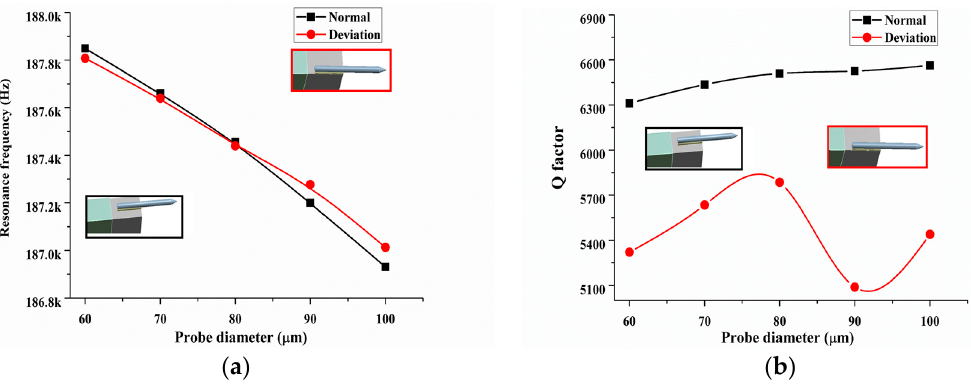
Figure 9. ( a ) Resonance frequency and ( b ) Q -factor changes with an increase of the tungsten probe diameters under a deviation of the probe position.